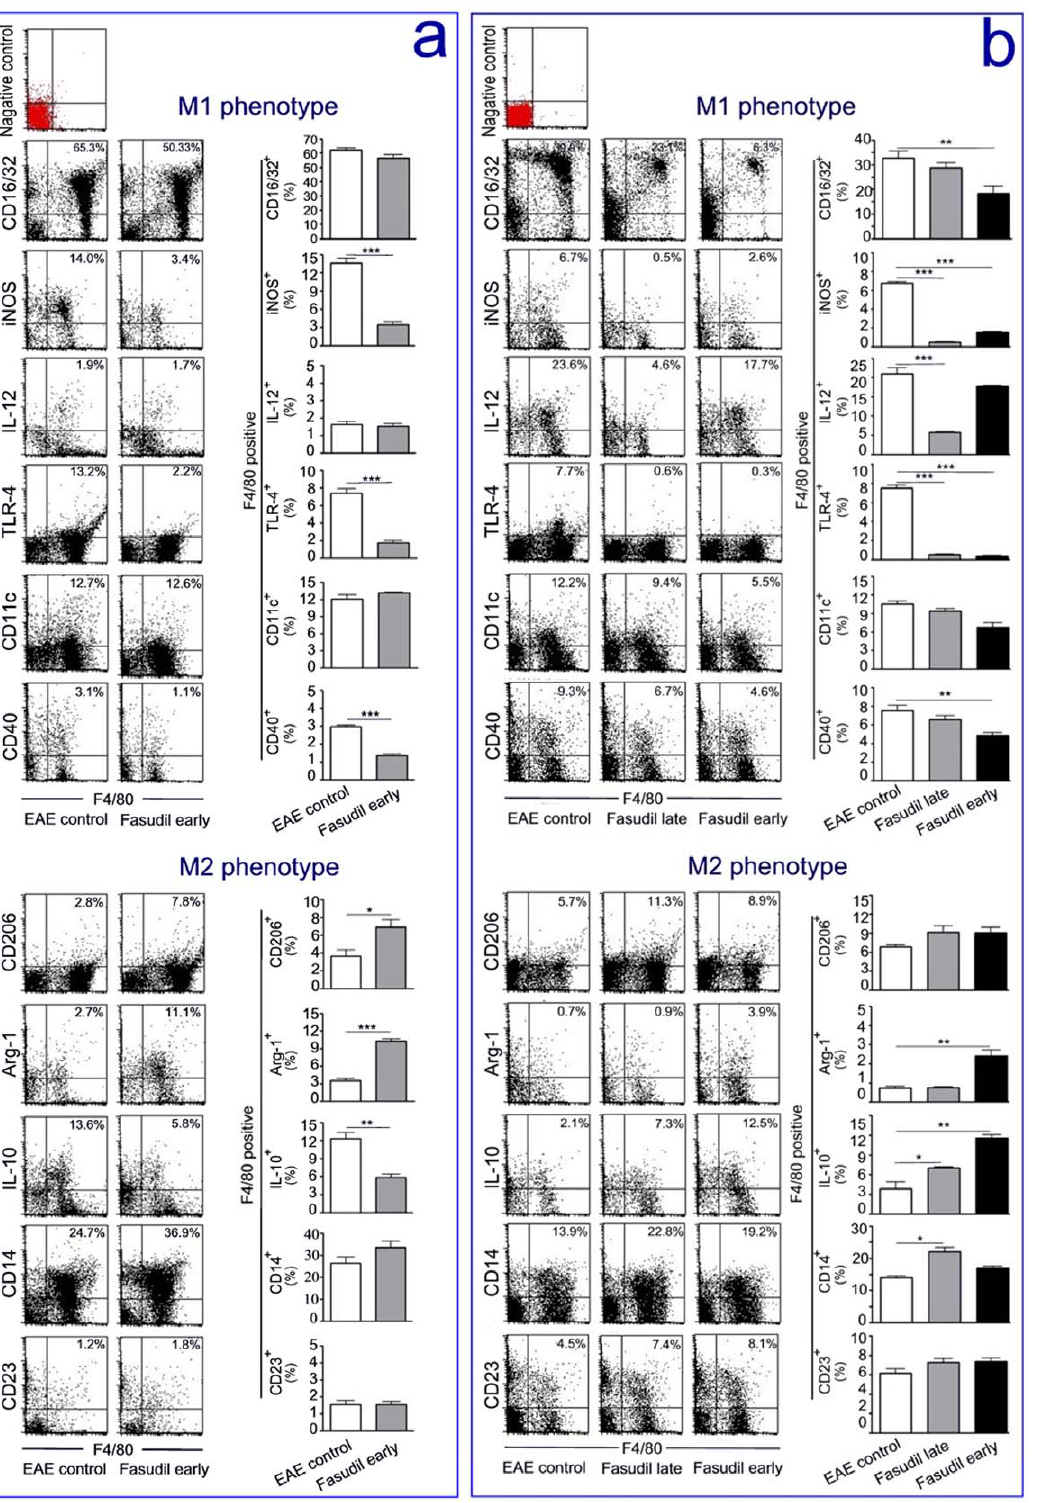
Figure 5. Fasudil shifts M1 to M2 phenotype. Chronic EAE was induced in C57BL/6 mice with MOG 35–55. Fasudil was injected (i.p.) at 40 mg/kg/ d every other day on day 3 and 11 p.i. Mice were sacrificed and splenic MNCs were prepared on day 9 (a) and 21 (b) p.i.. Cells were stained with macrophage marker F4/80 and M1/M2 markers, and the polarization of M1/M2 was analyzed using flow cytometry. Scatterplot, representative dot plots from one of three experiments with similar results. Histogram, quantitative results are analyzed for 5 mice in each group. Results are expressed as the percentage of double positive cells in four-quadrant diagram. * p , 0.05, ** p , 0.01, *** p , 0.001.